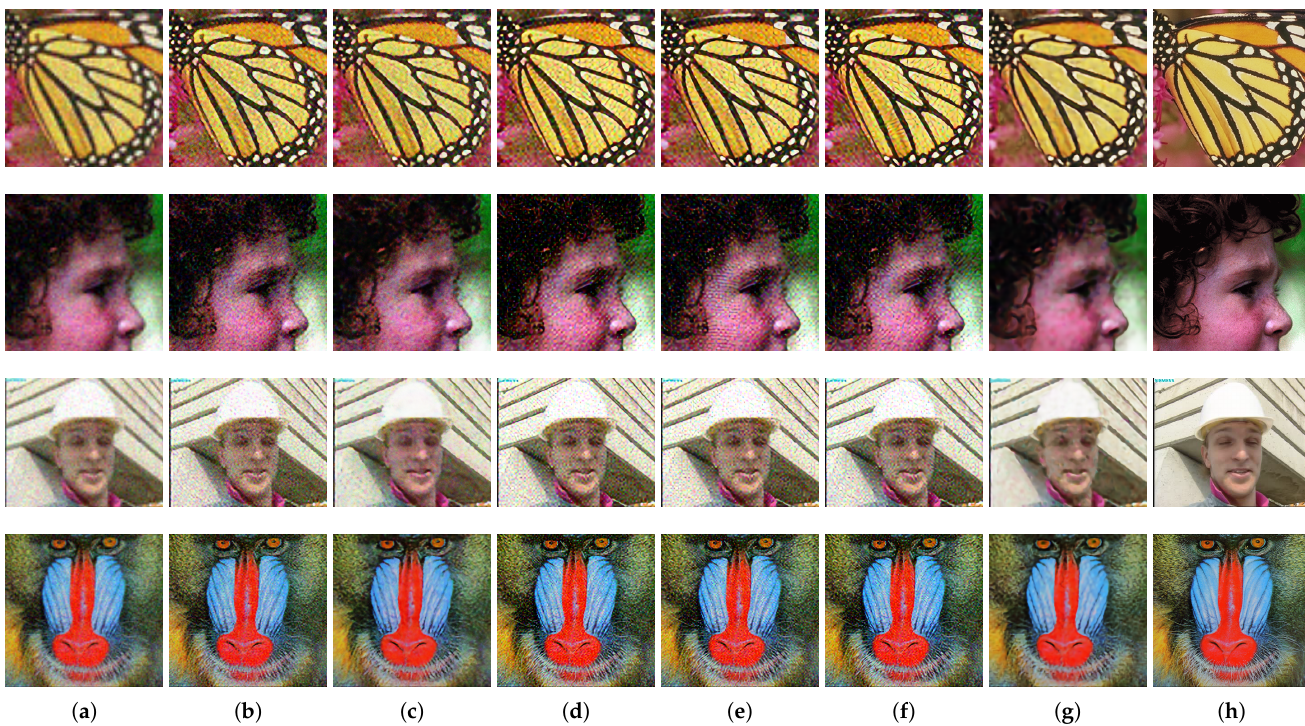
Figure 5. Qualitative comparisons of Set5 [11] and Set14 [12] ( × 4, σ = 15). ( a ) Bicubic, ( b ) DIP-SR [1], ( c ) DIP-Seq, ( d ) DRLN [22],